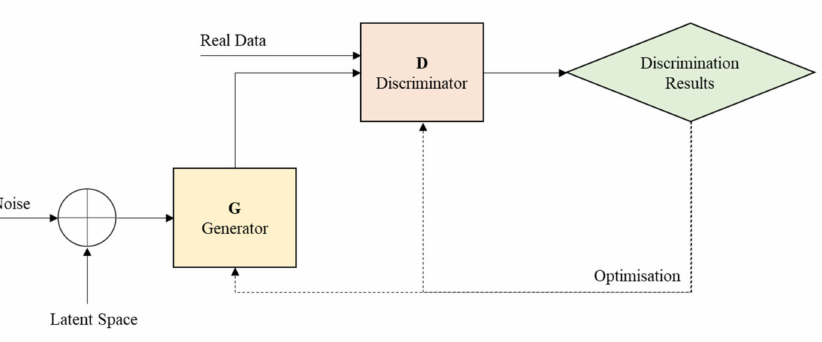
Figure 4. The general architecture of